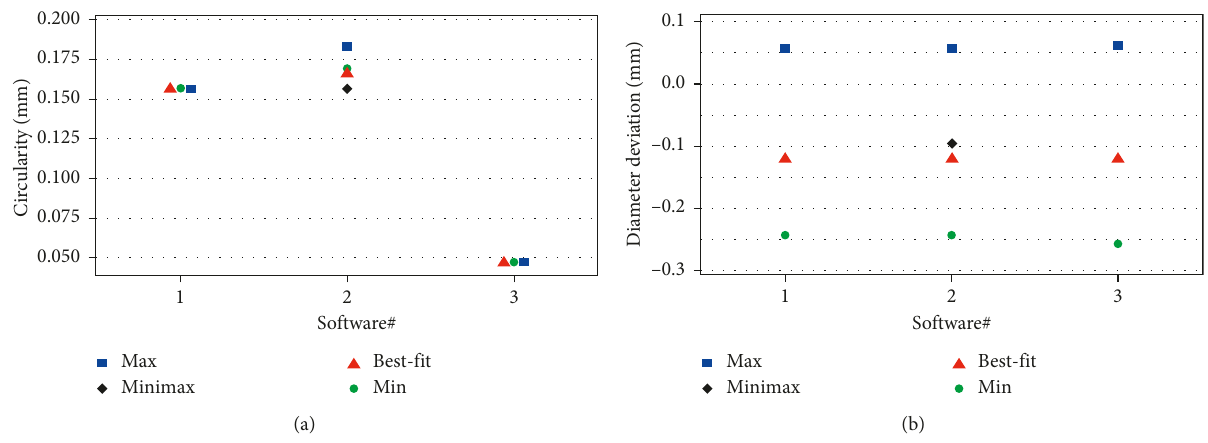
Figure 5: Results for circle #1. (a) Circularity tolerance. (b) Feature of size deviation δ